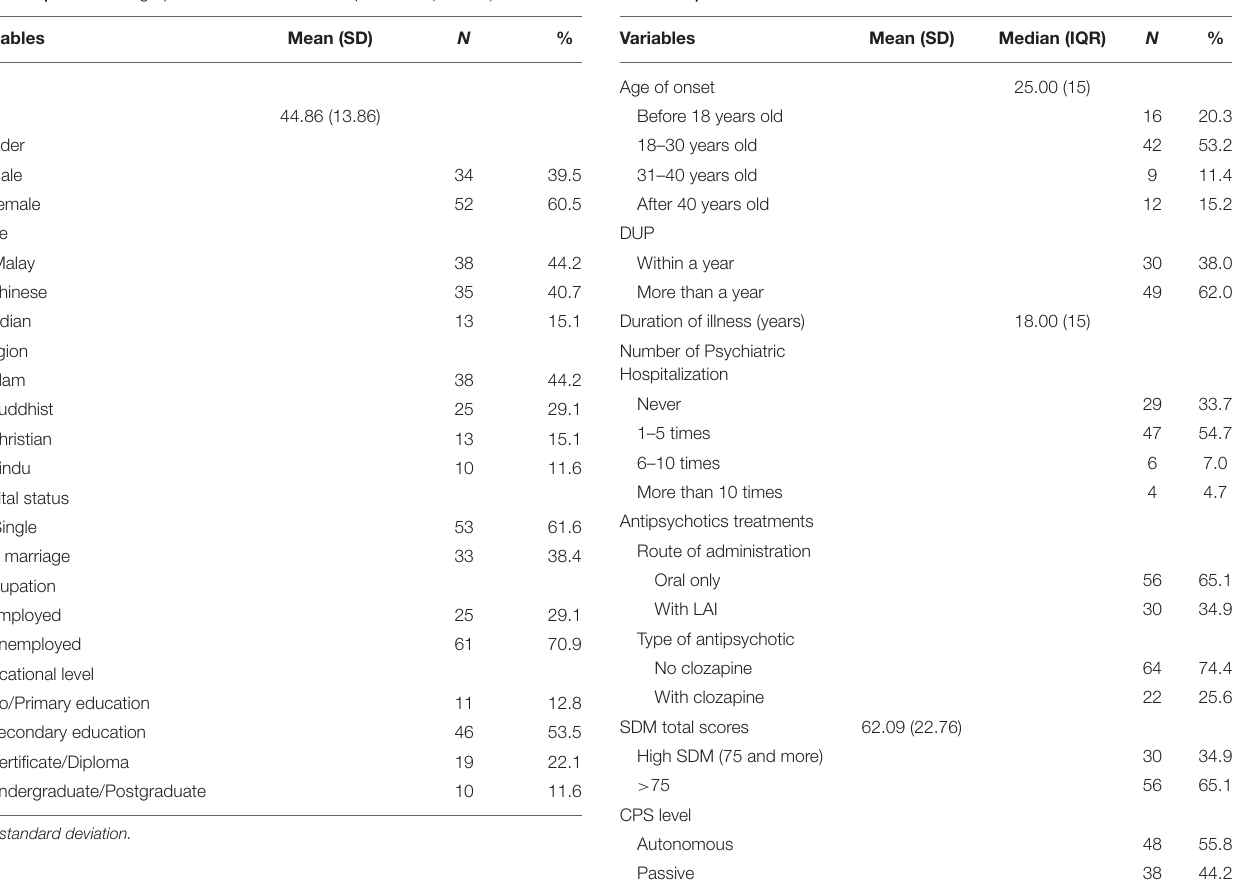
TABLE 2 | Clinical characteristics, SDM scores, CPS level, and SAI